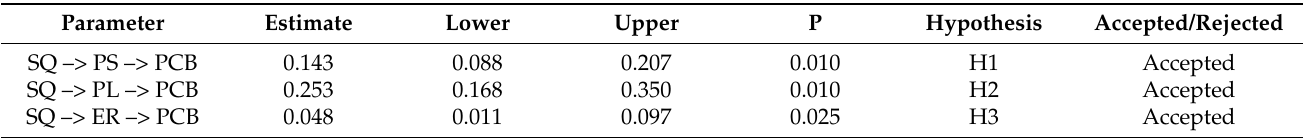
Table 4. Mediating Effects Between